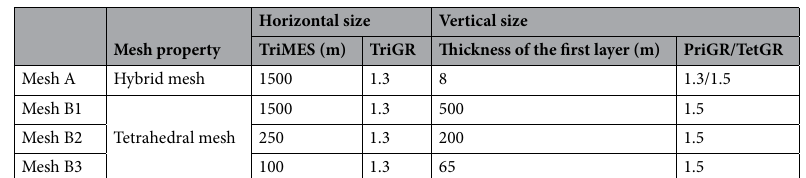
Table 1. Parameters of different meshes for the three-dimensional layered model.l layered model. MES means maximum unit size. The horizontal size is controlled by the triangular MES (TriMES) at the Earth’s surface and triangular growth rate (TriGR). The TriGR represents the maximum element growth rate of the triangular element size. Vertical size is controlled by the thickness of the prismatic layer and tetrahedral growth rate (TetGR). The TetGR represents the maximum element growth rate of the tetrahedral element size. The prismatic growth rate (PriGR) represents the vertical prismatic element growth rate of the prism layer thickness